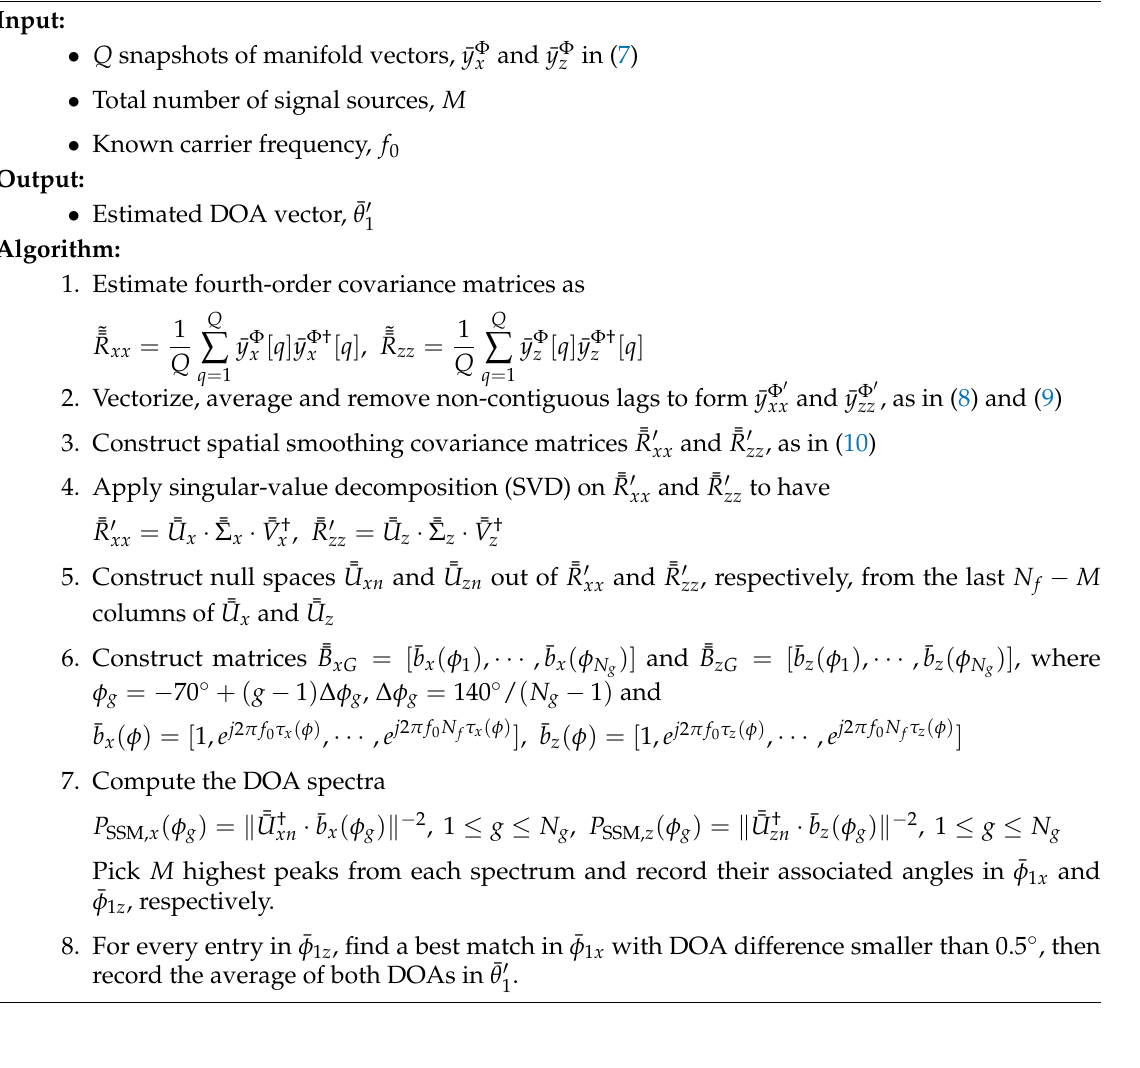
nearest grid points, and record them in ¯ φ 1 x and ¯ φ 1 z , respectively. Next, for every entry in ¯ φ 1 z , find the best match in ¯ φ 1 x with DOA difference smaller than 0.5 ◦ , then record the average of these two DOAs in ¯ θ (cid:48) . 1 Algorithm 1 SS-MUSIC based on two orthogonal